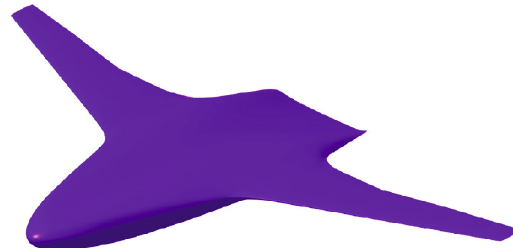
Figure 3: The SWB con fi guration.